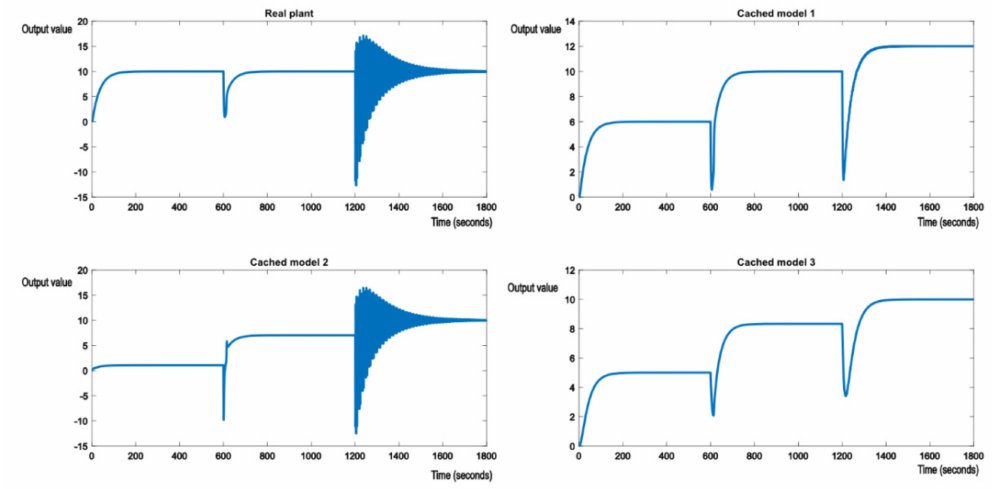
Figure 12. Switching from the initial model to cached model 1 and then to cached model 2, a poorly dumped second order transfer